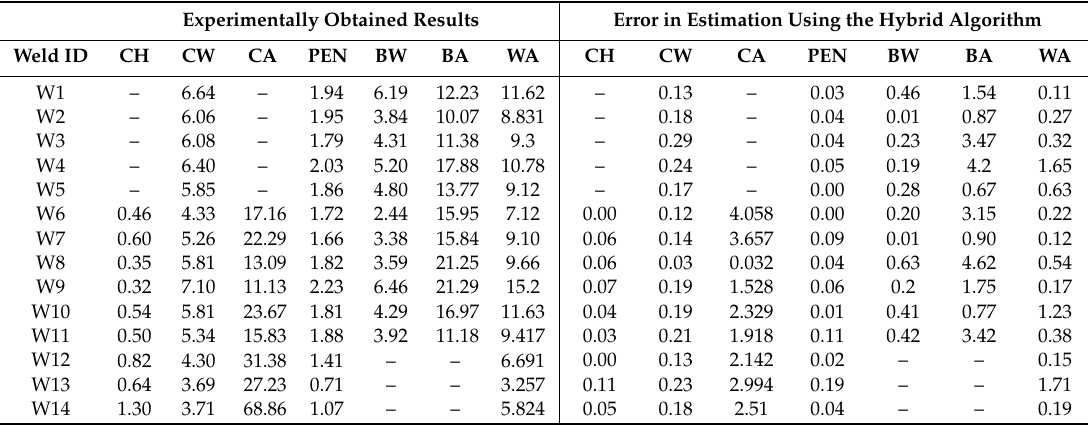
Table 6. Experimentally obtained results for welds done using the same parameters as in Table 5 and the corresponding errors in predicting the geometrical